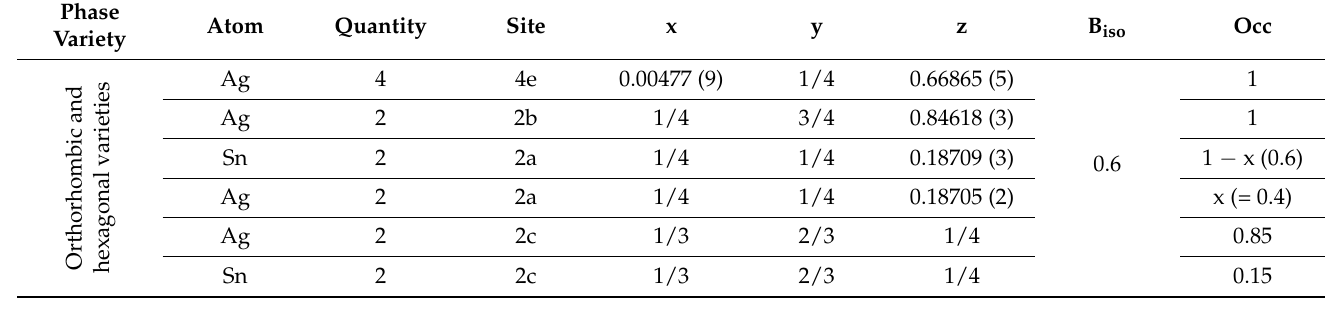
Table 3. Atomic positions in hypothesis (iii): presence of the two allotropic varieties.